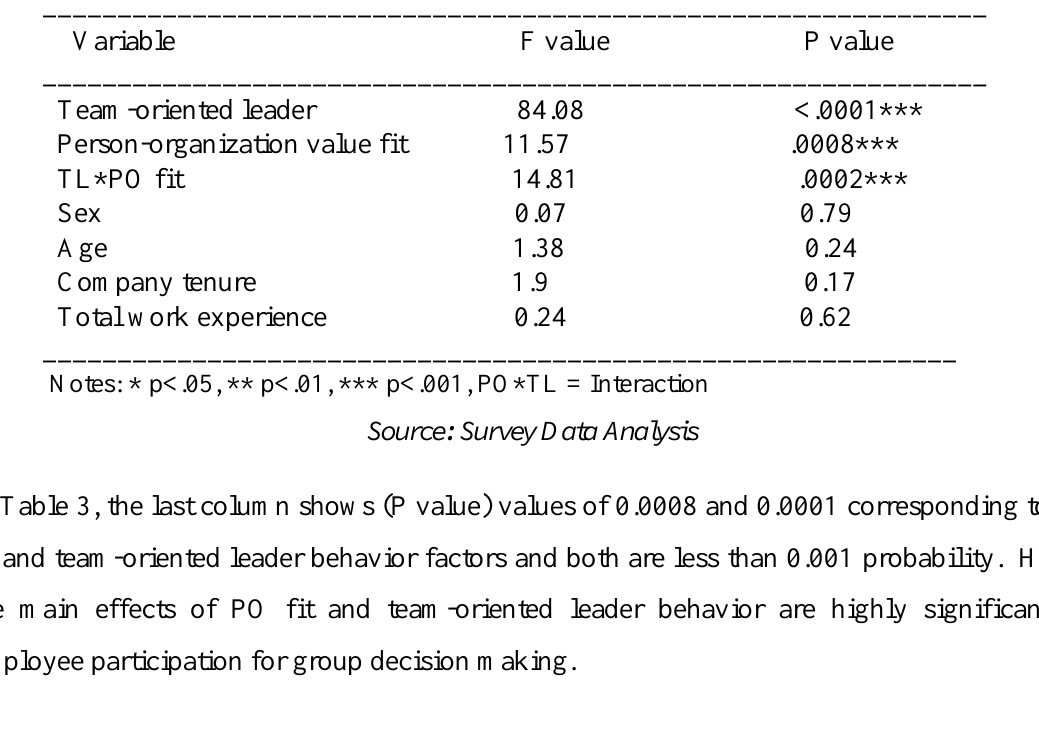
Table 2: Dependent Variable = Employee